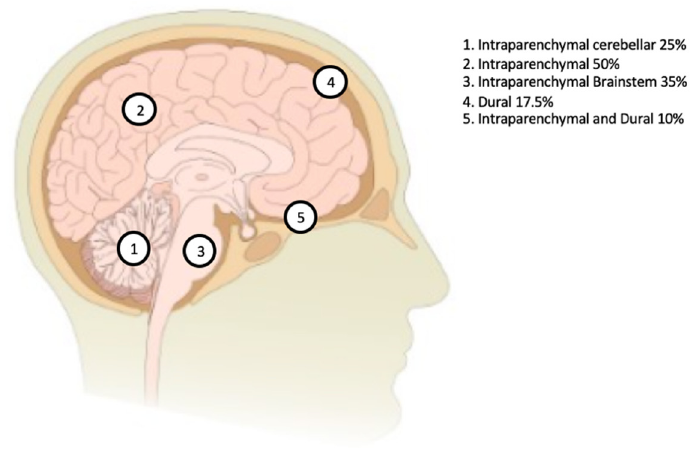
Figure 2. Locations of the intracranial lesions as seen on an MRI depicted on the brain diagram. Table 2. Treatments and outcomes of cases in this systematic review.